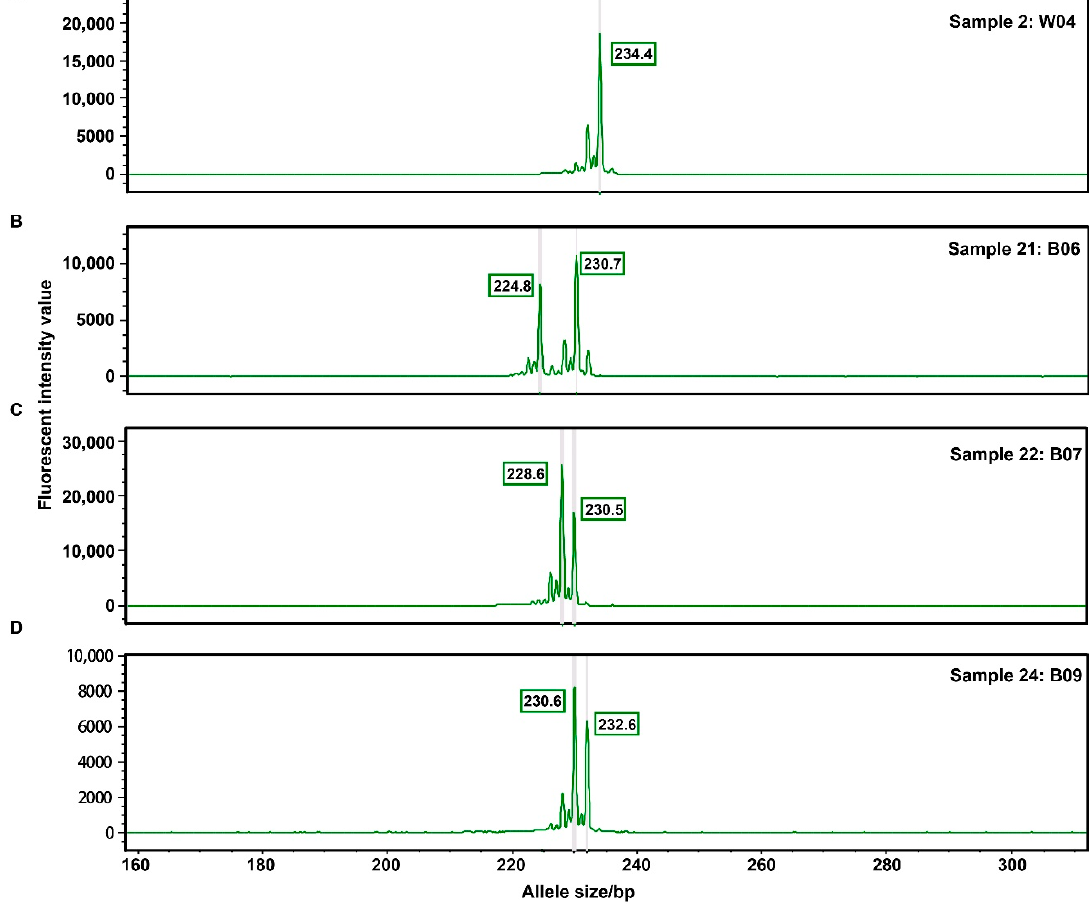
Figure 5. Different alleles of SSR located in chr1:272,578,714-272,578,954. The output data from capillary electrophoresis was analyzed by GeneMapper software (V2.2.0) and generated the allele report for 60 pigs. (A–D) Five alleles 224, 228, 230, 232 and 234 bp in length existed in chr1:272,578,714-272,578,954 bp are exampled in corresponding pig individuals. The X axis represents allele size, Y axis represents fluorescent intensity for different allele size, one or two peaks on the green line represents homozygosity and heterozygosity, respectively. The sample number W04 means the individual in the Wuzhishan pig breed. The sample number B06, B07 and B09 mean the individuals in Bama pig breed.